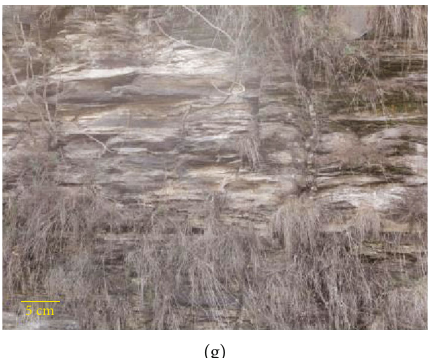
Figure 8: Outcrop of sublacustrine fan in southeastern Ordos Basin: (a) main channel deposits, Shanshui river pro fi le, Xunyi county; (b) main channel deposits and branch channel deposits, Shanshui river pro fi le, Xunyi county; (c) branch channel deposits and interchannel deposits, Shanshui river pro fi le; (d) lobe fringe deposits, Niejiashan pro fi le, Tongchuan city; (e – g) deep lake deposits, Tongchuan city.